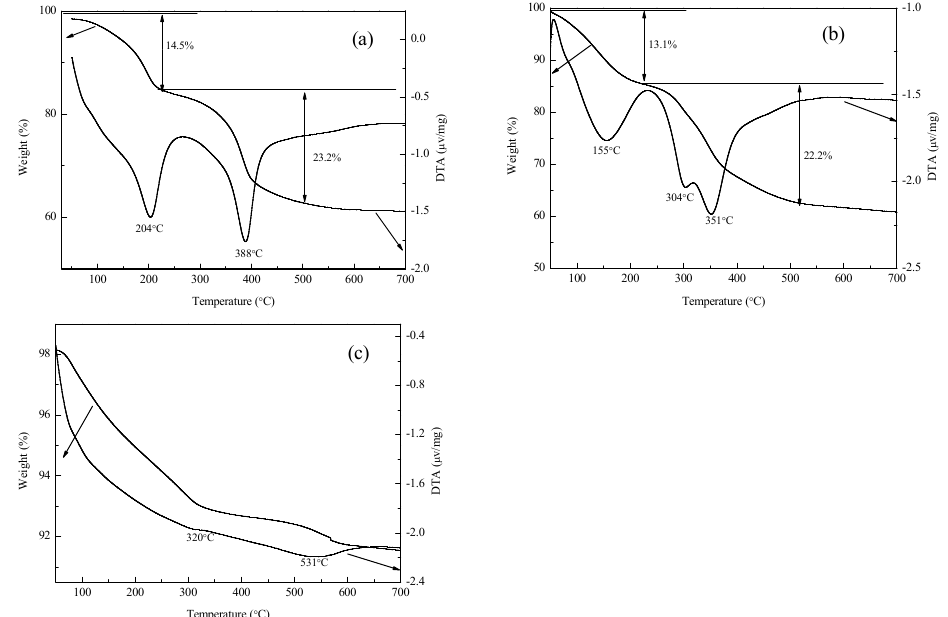
Figure 2. ( a ) TG-DTA curves of Mg-Fe-Ti-LDHs-CO 32 − , ( b ) Mg-Fe-Ti-LDHs-Cl − -2 and ( c ) Mg-Fe-Ti- CLDH.